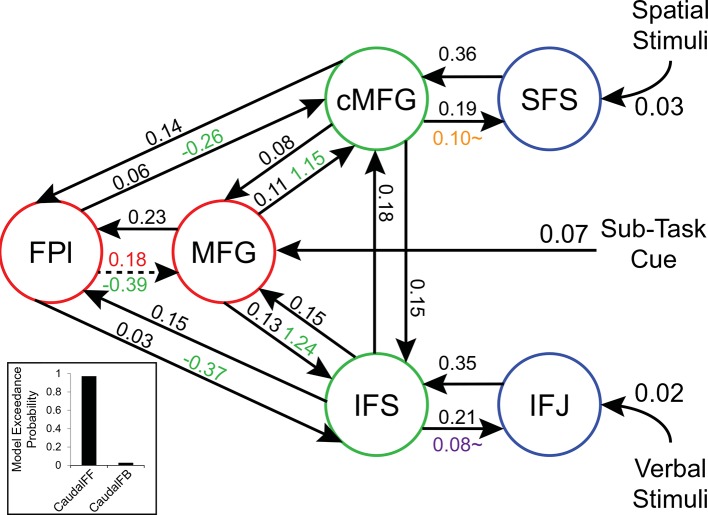
Path coefficients in a rostral-to-caudal model.Inference on parameters was performed on an alternative model of LPFC organization wherein content demands produced feedback modulations from mid areas to caudal areas. Notably, this is a strict rostral-to-caudal hierarchical model of modulations. Inset: Model comparison demonstrating the inferiority of this model (CaudalFB) to the chosen model depicted in Figure 6 (CaudalFF). These data stress the importance of explicit model comparison prior to inference on parameters. Details otherwise identical to Figure 6 – supplement 1. ~q<0.05, one-tailed.